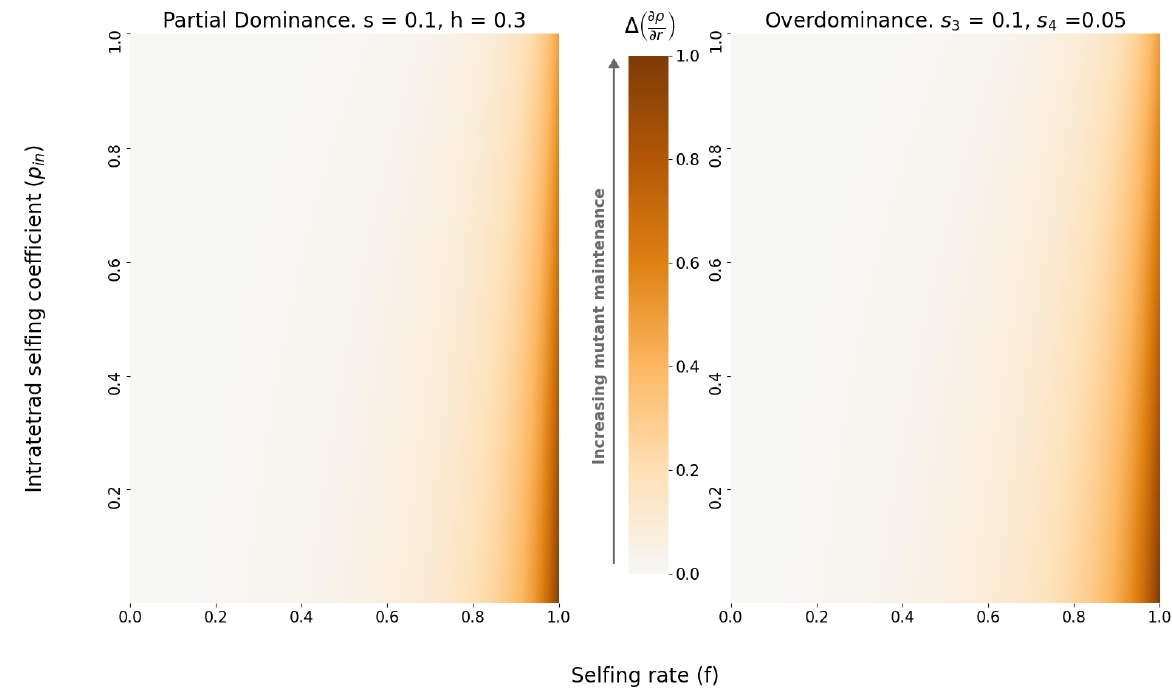
Figure S4 – Difference between the dominant eigenvalue derivative at r = 0.5 and at ∂ρ ∂ρ = ∂ρ r = 0 , ∆ ∂ r ∂ r | r =0.5 − ∂ r | r =0 . The left panel shows the partial dominance case, the (cid:17) (cid:16) right panel shows the overdominance case, for varying selfing rate f (x-axis), and intra- tetrad selfing rate (y-axis). The difference is always positive, with both derivative being negative (see App. E.3 and App. F.3). This means that the absolute value of the derivative at r = 0 is always greater than the absolute value of the derivative at r = 0.5 . The darker the color, the larger the difference between the two